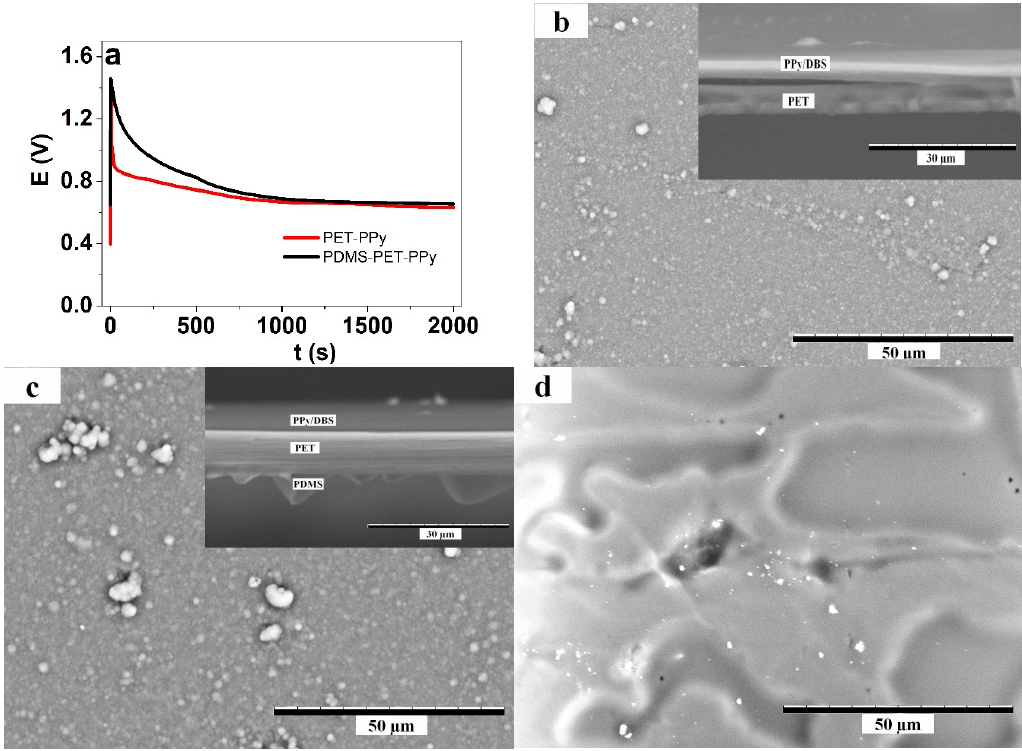
Figure 1. PPy deposited on PET and (PDMS) PET sheets with conductive coatings based on PEDOT: PSS/MWCNT showing ( a ) the galvanostatic polymerization (0.2 mA cm − 2 ) at room temperature obtaining PET-PPy (red line) and (PDMS) PET-PPy (black line) bilayers. The SEM surface images (scale bar 50 µm) presenting ( b ) the surface morphologies of PET-PPy (inset cross section, scale bar 30 µm) and ( c ) (PDMS) PET-PPy (surface and cross section). ( d ) The surface image of PDMS coatings on PET.